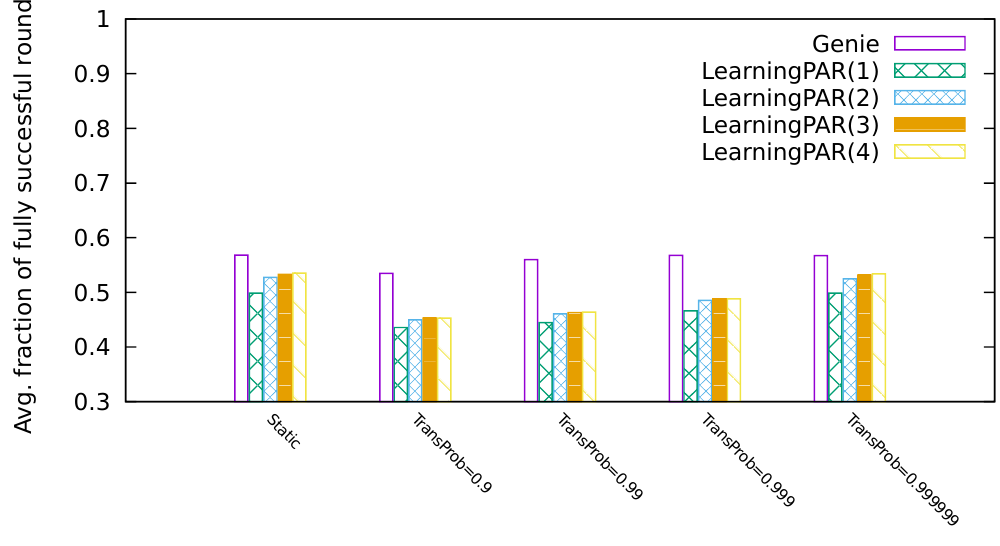
Figure 5. Average fraction of successful